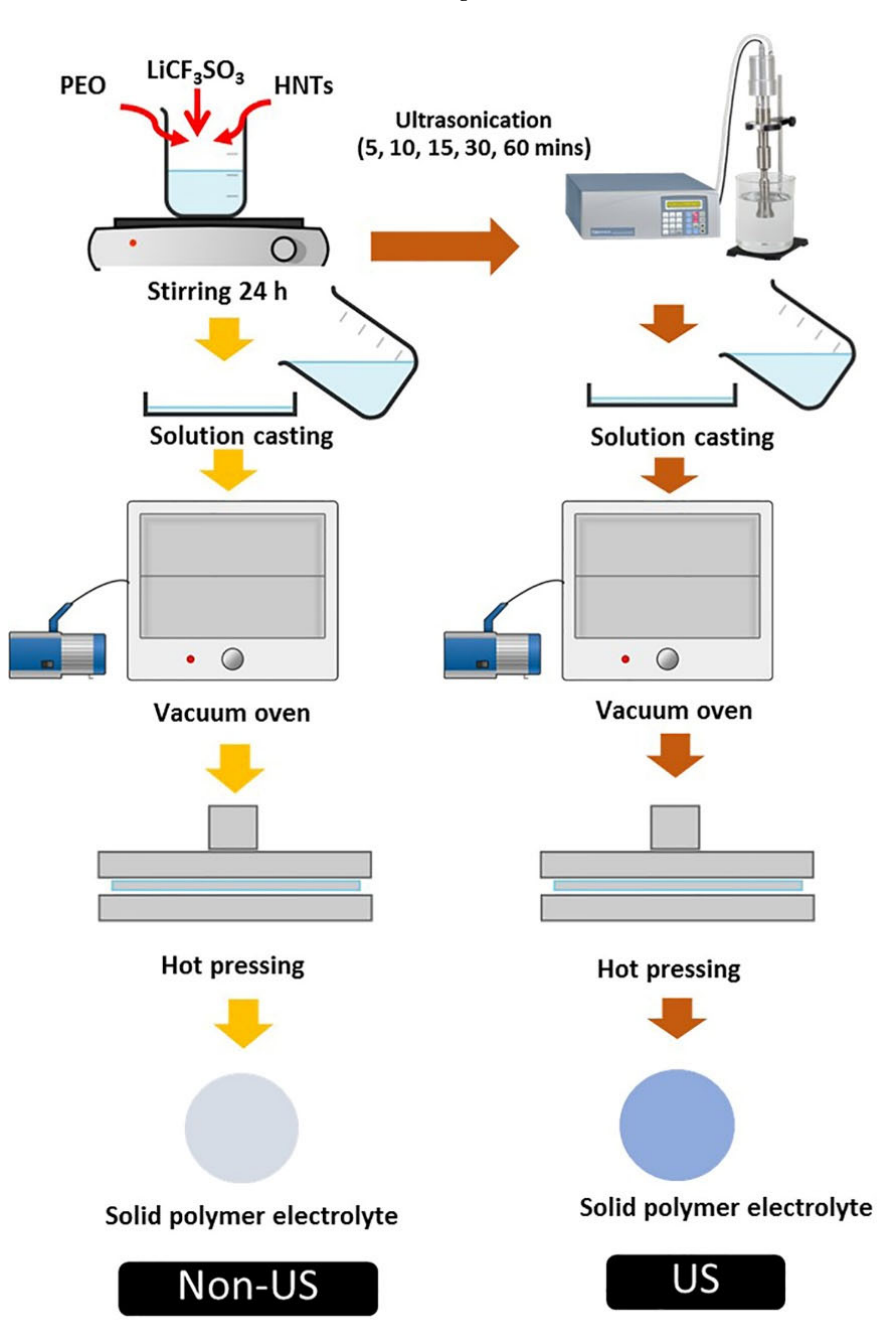
Figure 1. Schematic outline of the two fabrication routes for solid polymer electrolyte nanocompo ‐ site.